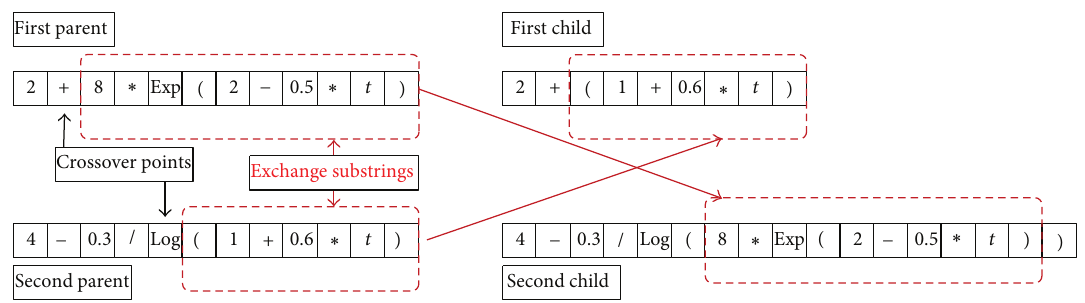
Figure 5: Crossover of the modified-hybrid Genetic Programming method (string representation).